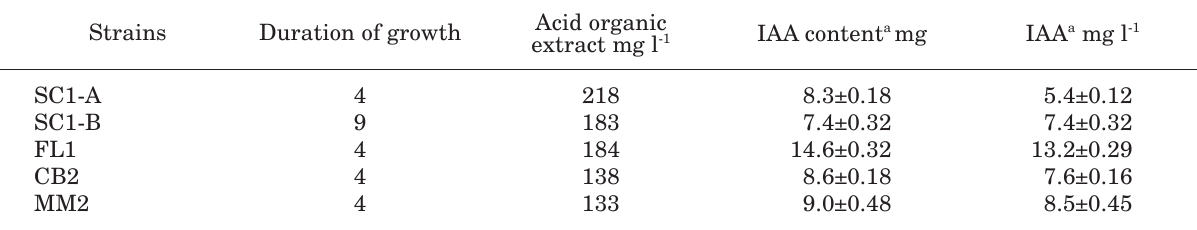
Fig. 1. The structural formulae of indole-3-acetic acid, indole-3-ethanol and indole-3-aldehyde ( 1 , 2 and 3 ) isolated from Pantoea Table 3. IAA content in the culture filtrates of various P. agglomerans strains.